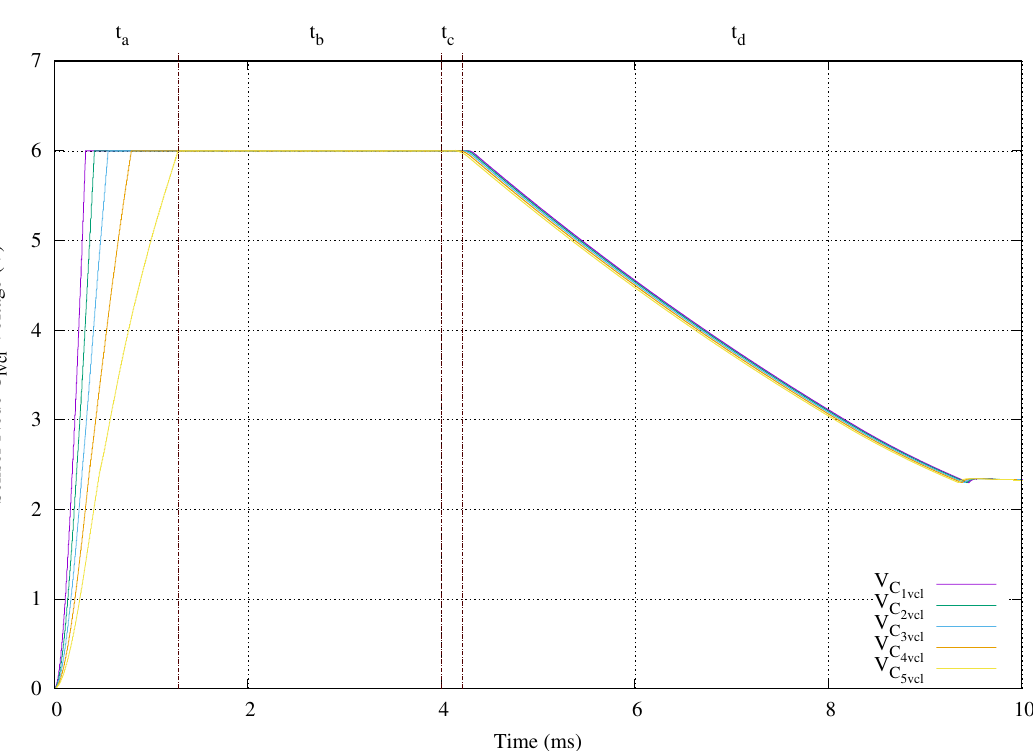
) behavior when a 4 ms tone of 134.2 kHz is ivcl